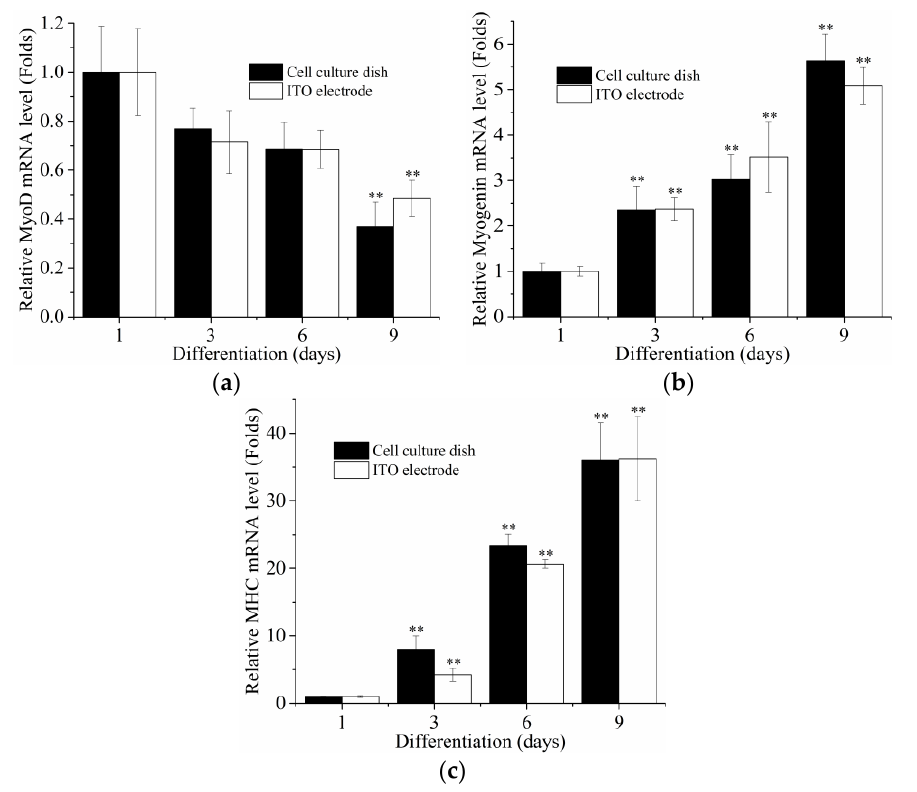
Figure 4. Expression of mRNA for ( a ) MyoD; ( b ) Myogenin; and ( c ) myosin heavy chain (MHC) was analyzed by qRT-PCR during differentiation (Days 1, 3, 6 and 9) on a cell culture dish or on the ITO electrode ( n = 3). Relative expression was normalized to cyclophilin expression. ** p < 0.01 compared with Day 1.